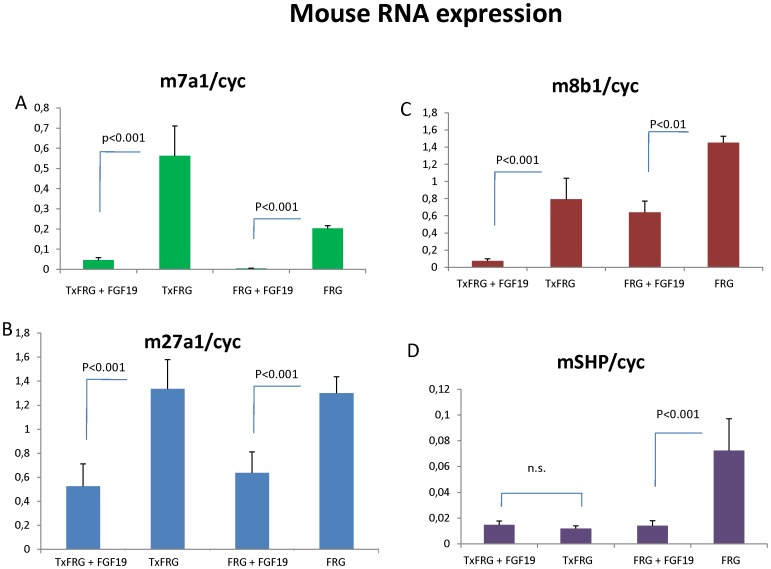
Expression of mouse RNA.A, Cyp7a1, B,Cyp27a1, C, Cyp8b1, and E, SHP in livers of both FRG and humanized FRGN mice (TxFRG), with or without FGF19 (TxFRG+FGF19, FRG+FGF19). Statistics were performed by a 1-way ANOVA on log-transformed data followed by LSD test.